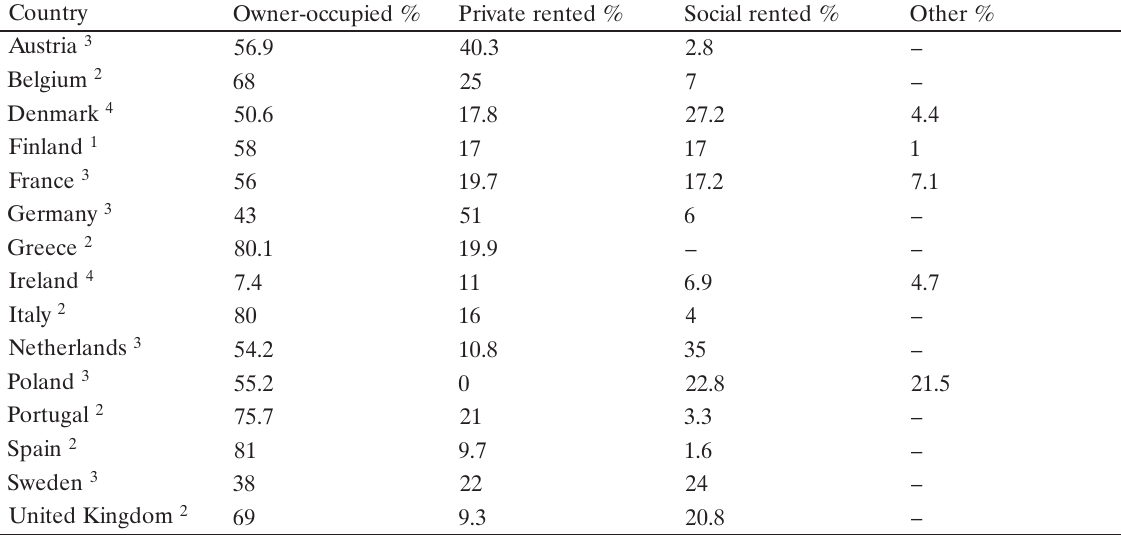
Table 1. Division of the housing stock by tenure yrtnuoC %deipucco-renwO %detneretavirP %detnerlaicoS airtsuA 3 muigleB 2 kramneD 4